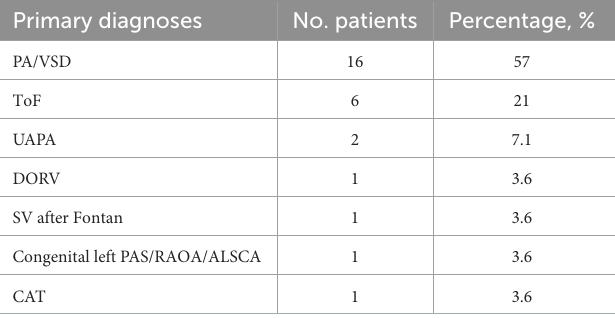
TABLE 4 Angioplastic parameters during